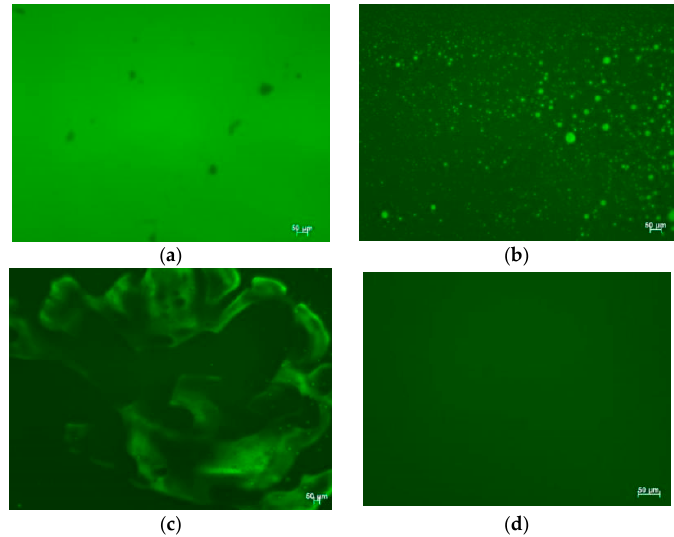
Figure 6. The fluorescence microscope (FM ) images: ( a ) Pen 60/70; ( b ) modified bitumen with 6% WEB additive; ( c ) modified bitumen with 8% WEB additive; and ( d ) WEB additives.